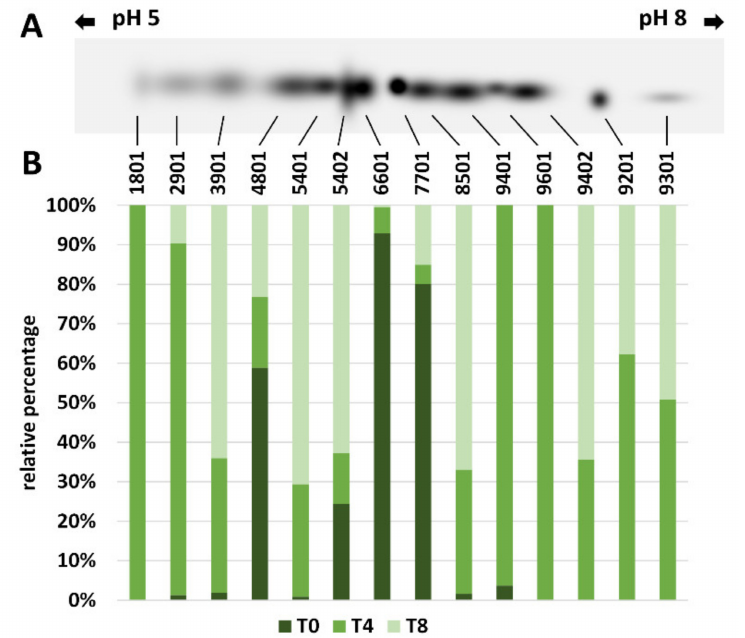
Figure 11. 2-D analysis of RubisCO in Olivastra Seggianese plants. ( A ) Master blot of RubisCO isoforms at T0, T4 and T8 of UV-B stressed plants of Olivastra Seggianese. Each spot is identified with a numerical code. ( B ) Graph of the relative quantification of immunoblot intensities for each spot. Each spot is indicated in percentage relative to each individual analysis